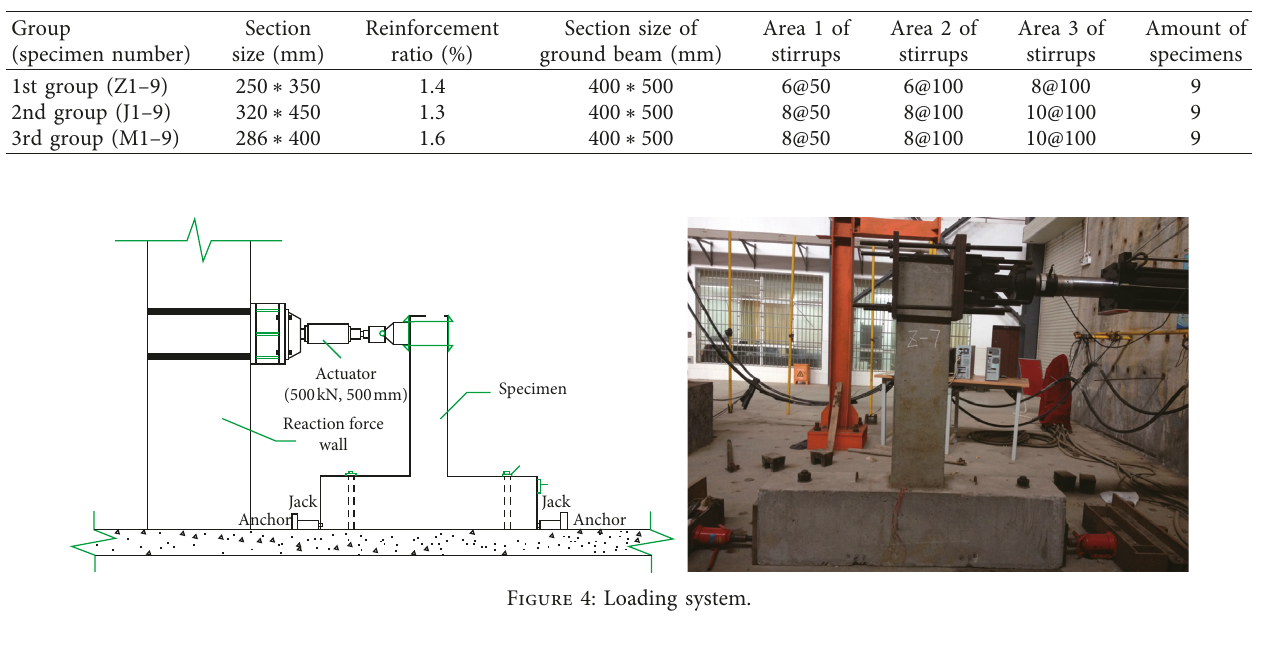
Figure 4: Loading